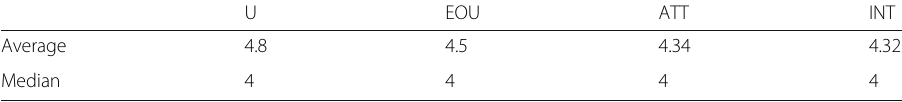
Table 7 Averages and medians of learner ’ s